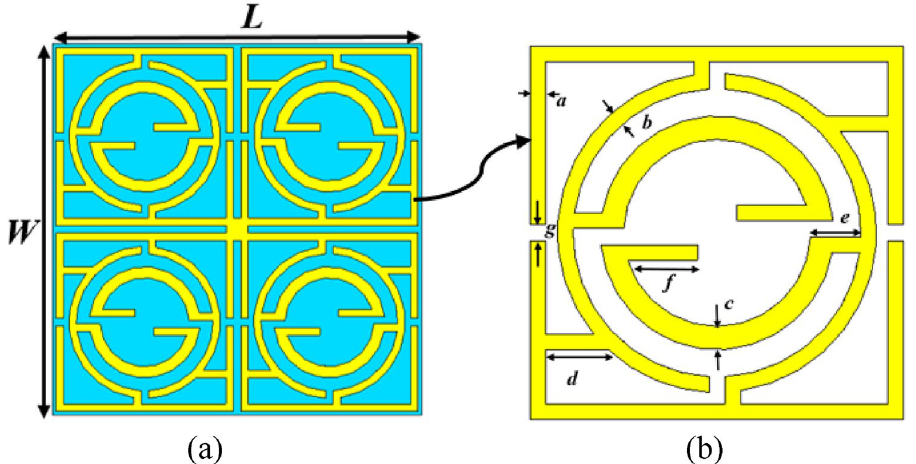
Figure 1. Front view of the proposed MTM unit cell: ( a ) total patch layout, ( b ) enlarged view of a segment of the patch (CST microwave studio suite 2019).